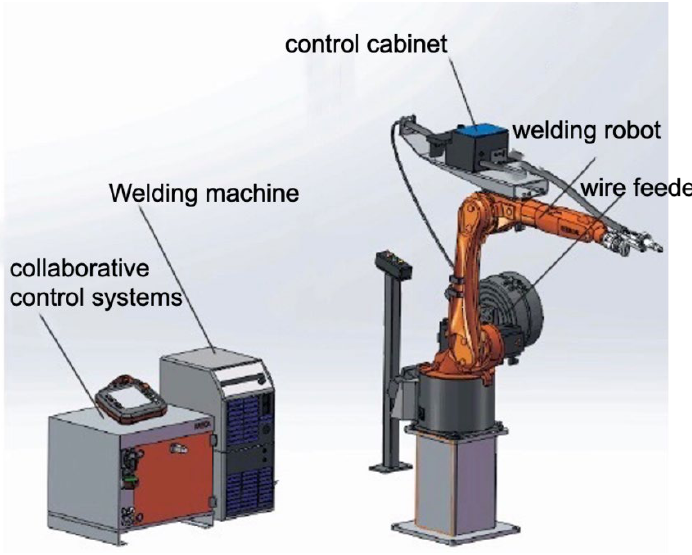
Figure 5. Robot WAAM system.